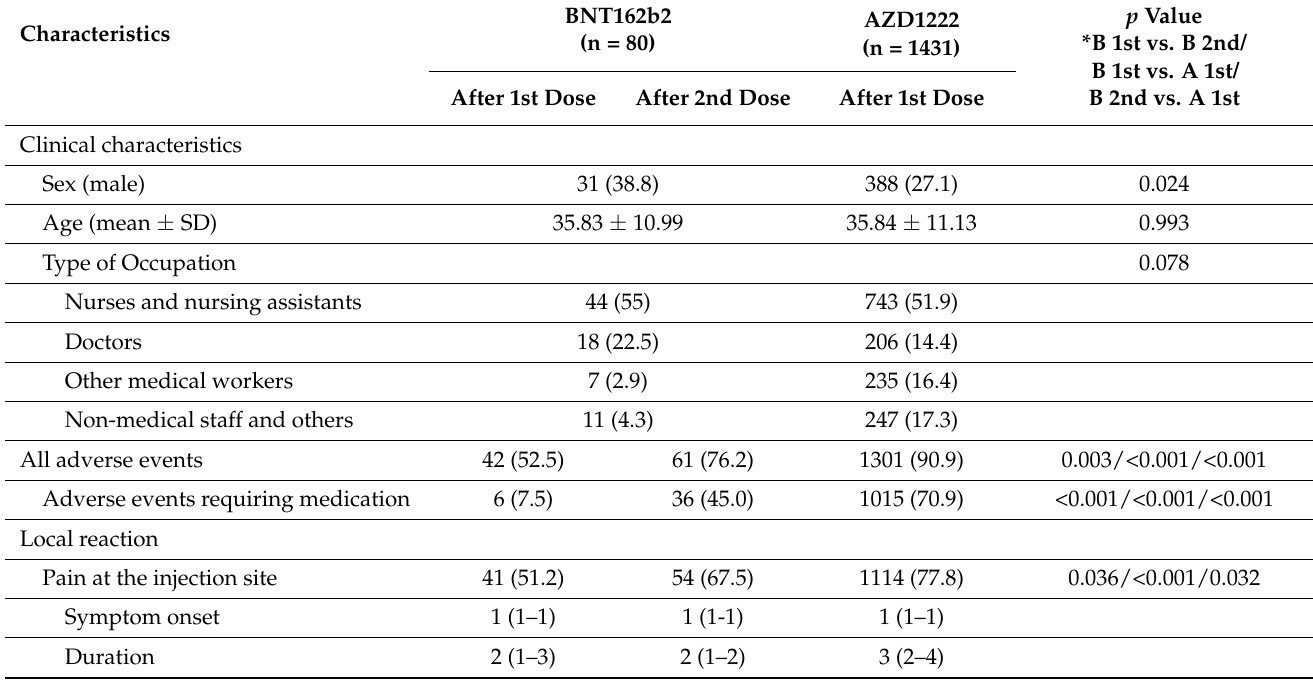
Table 1. Adverse events following